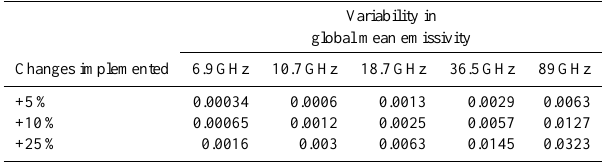
Table 1. Sensitivity of the emissivity retrieval in terms of global average change of emissivity (horizontal polarization) to 5, 10, and 25% increase in water vapor